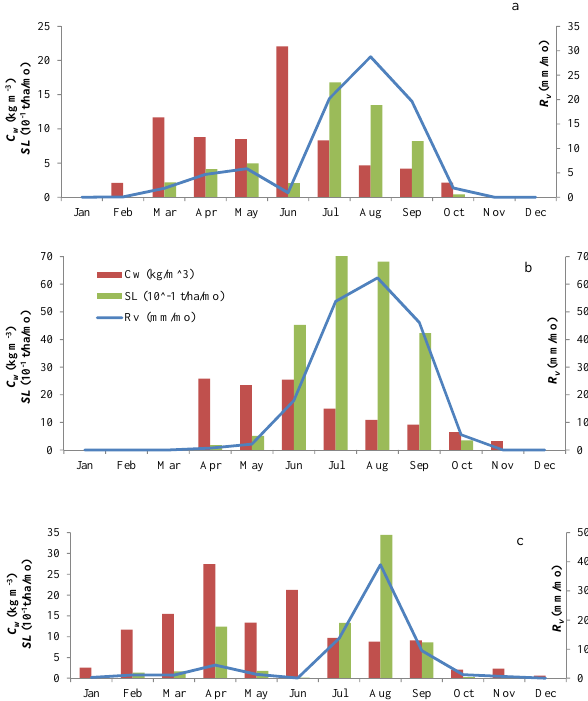
Fig. 2. Mean monthly sediment concentration ( C w in kg m -3 ; primary y-axis), mean monthly sediment load (SL in t ha -1 mo -1 ; primaryy-axis), and mean monthlydischarge ( R v in mm mo -1 ; secondary y-axis) using only storm runoff for (a) Andit Tid (b) Anjeni (c) Maybar.